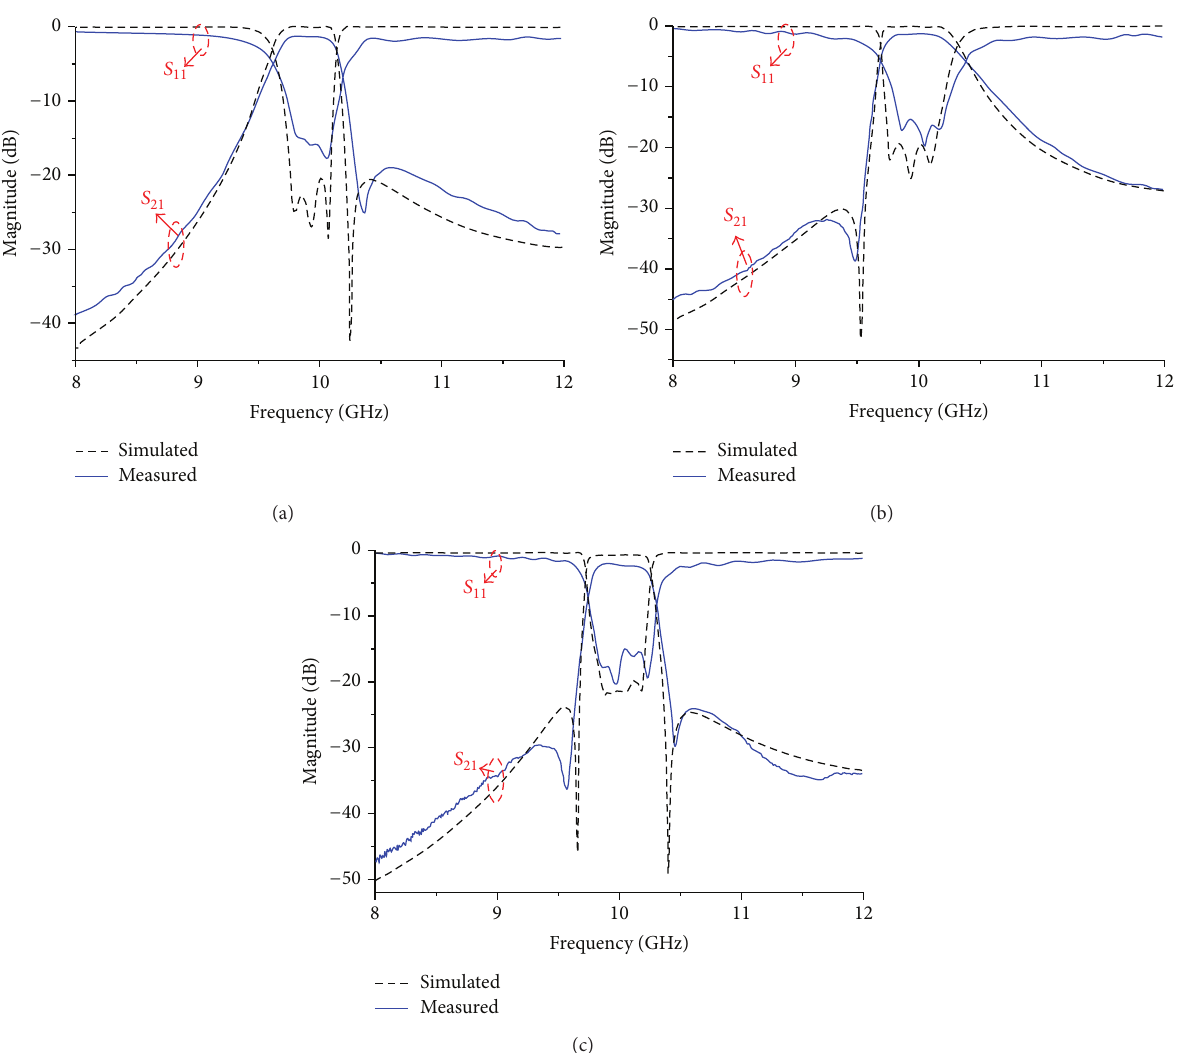
Figure 7: Simulated and measured frequency responses: (a) Filter A, (b) Filter B, and (c) Filter C,